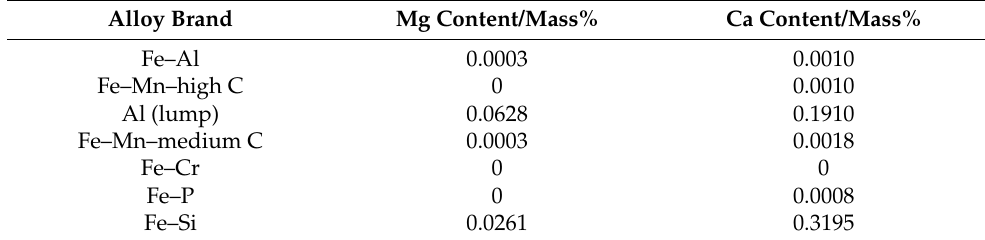
Table 3. Alloying materials and the Mg and Ca